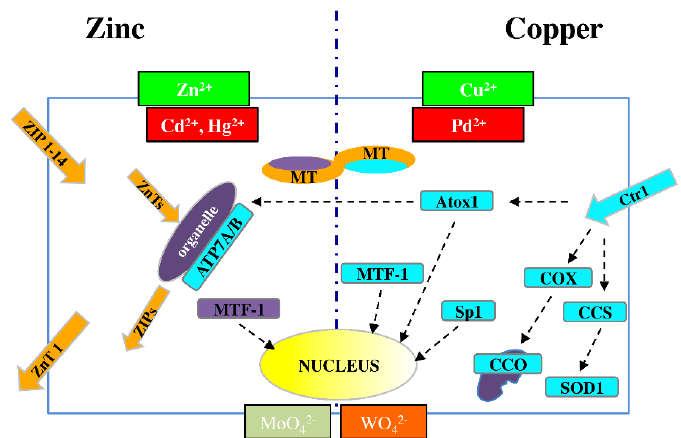
Figure 1. Schematic picture of dynamic metal homeostasis (metallostasis) players for Zn 2 + ( left ) and Cu 2 + ( right ). As a result of chemical similarities, Cd 2 + and Hg 2 + can compete with Zn 2 + , while Pd 2 + can compete with Cu + for cellular transport and binding proteins. Similar competition can occur between molybdenum and tungsten. ZIP (14 members) = membrane protein transporters for Zn 2 + influx; ZnT (10 members) = membrane protein transporters for Zn 2 + e ffl ux; MT = metallothioneins; MTF-1 = metal-responsive transcription factor-1; APT7A / B = metal-transporting P-type ATPase A and B; Ctr1 = membrane protein for copper uptake; Atox1 = antioxidant 1 copper chaperon; COX = cytochrome c oxidase copper chaperon; CCO = cytochrome c oxidase; CCS = copper chaperon for superoxide dismutase; SOD1 = superoxide dismutase 1; Sp1 = transcription factor specific protein